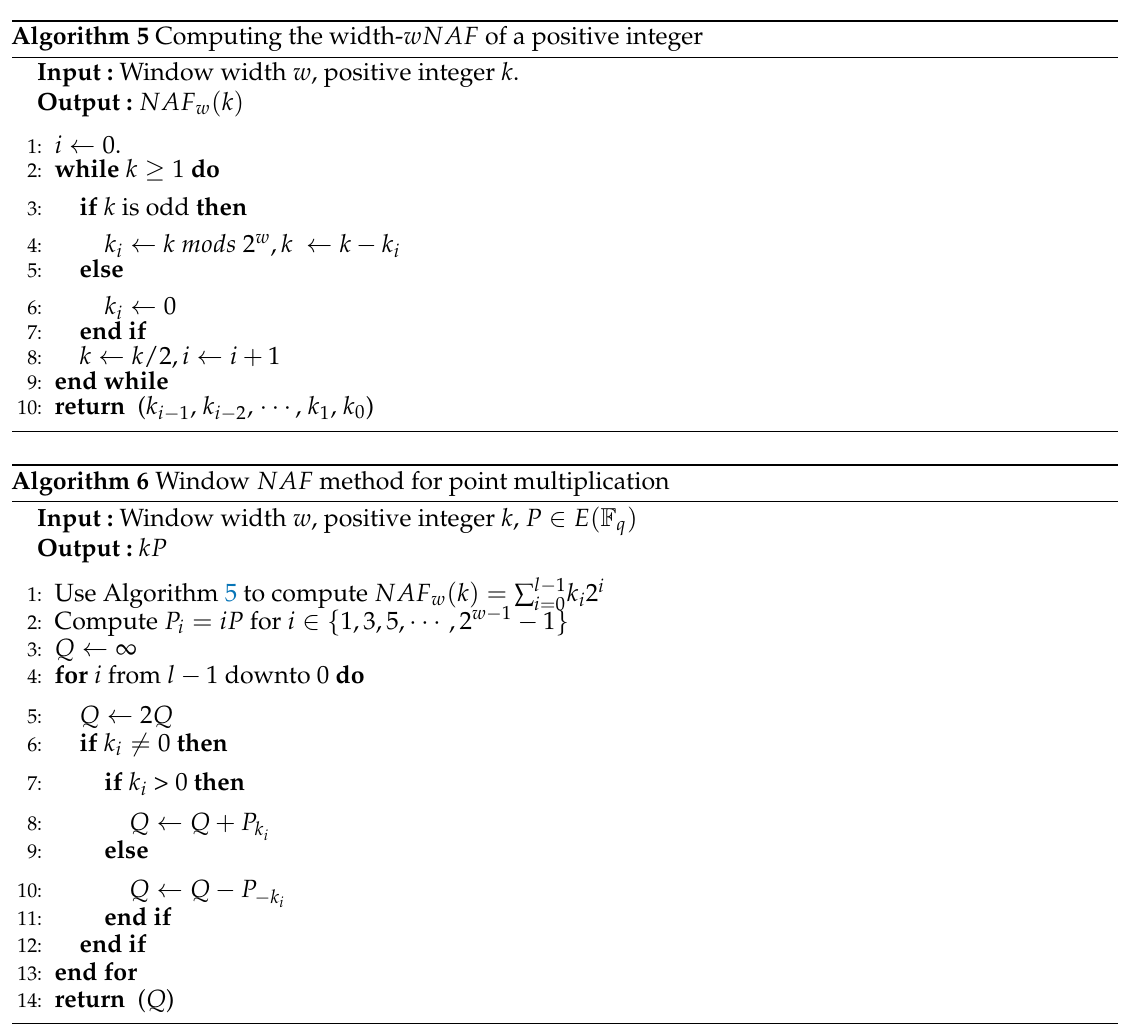
Algorithm 5 Computing the width- wNAF of a positive integer